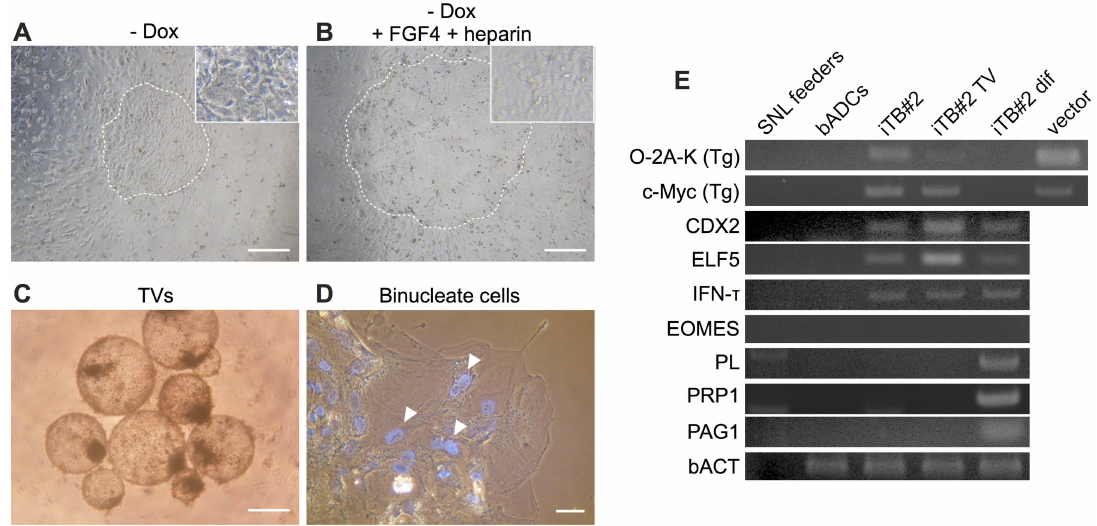
Fig 5. Differentiation potential of bovine-induced trophoblastic cells (biTBCs). (A) Phase-contrast image of biTBCs culturedin the absenceof Dox (- Dox) for 7 days. The circled dotted area indicatesthe colony. (B) Phase-contrast image of biTBCs culturedin the absenceof Dox and in the presenceof FGF4 and heparin for 7 days. The circled dotted area indicates the colony. (C) Phase-contrast image of TVs generatedfrom biTBCs. (D) Phase-contrast image of differentiated biTBCs. Nuclei were stained with Hoechst. Arrowheadsindicatebinucleated cells. (E) Endogenousand exogenousgene expressionin differentiated biTBCs. iTB#2: Inducedtrophoblast cell line #2; iTB#2 TV: TVs generatedfrom biTBC line #2 by culturingin low- adhesion culture dishes for 6 days; iTB#2 dif, biTBC line #2 after culturingin the absenceof Dox for over 30 days. (A)-(C) scale bars = 500 μ m. (D) scale bars = 70 μ